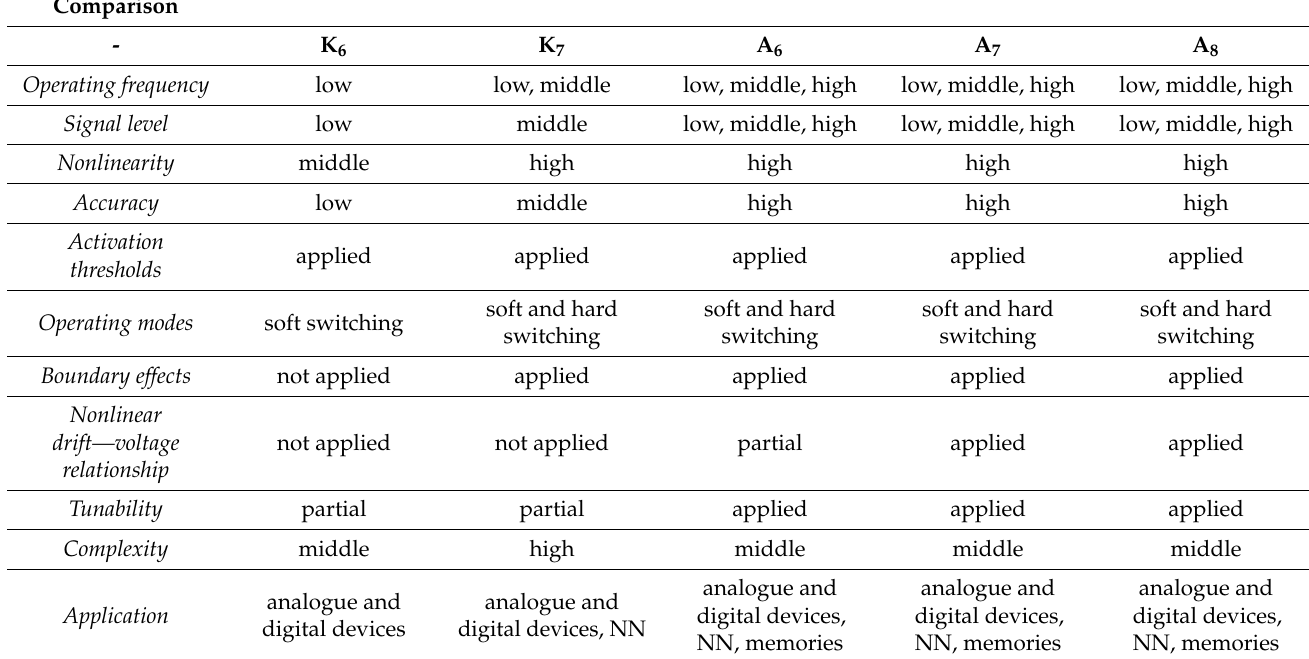
Table 2. Comparison of the considered existing and modified HfO 2 memristor models.